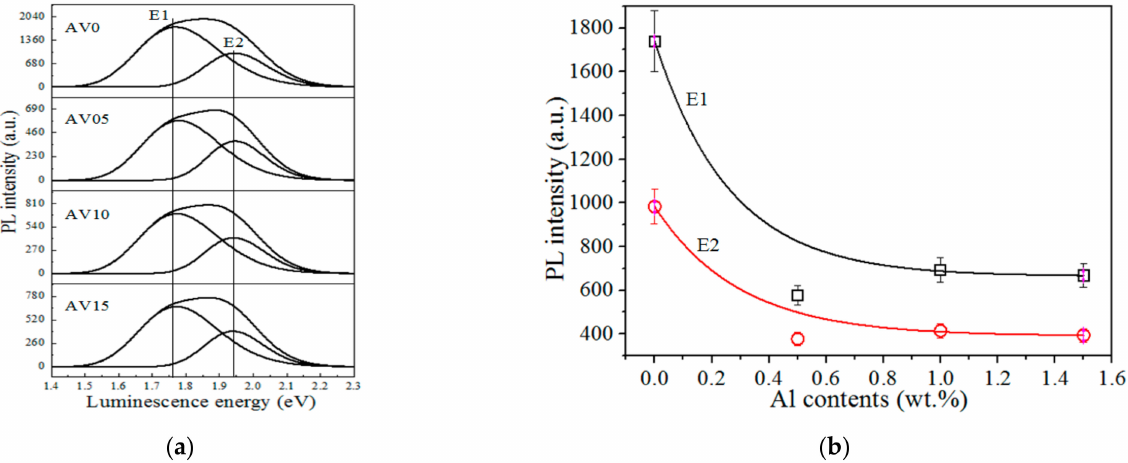
Figure 5. ( a ) Photoluminescence (PL) spectra of the samples AV0, AV05, AV10, and AV15 NSs; and ( b ) intensities of the E1 and E2 varying with the Al